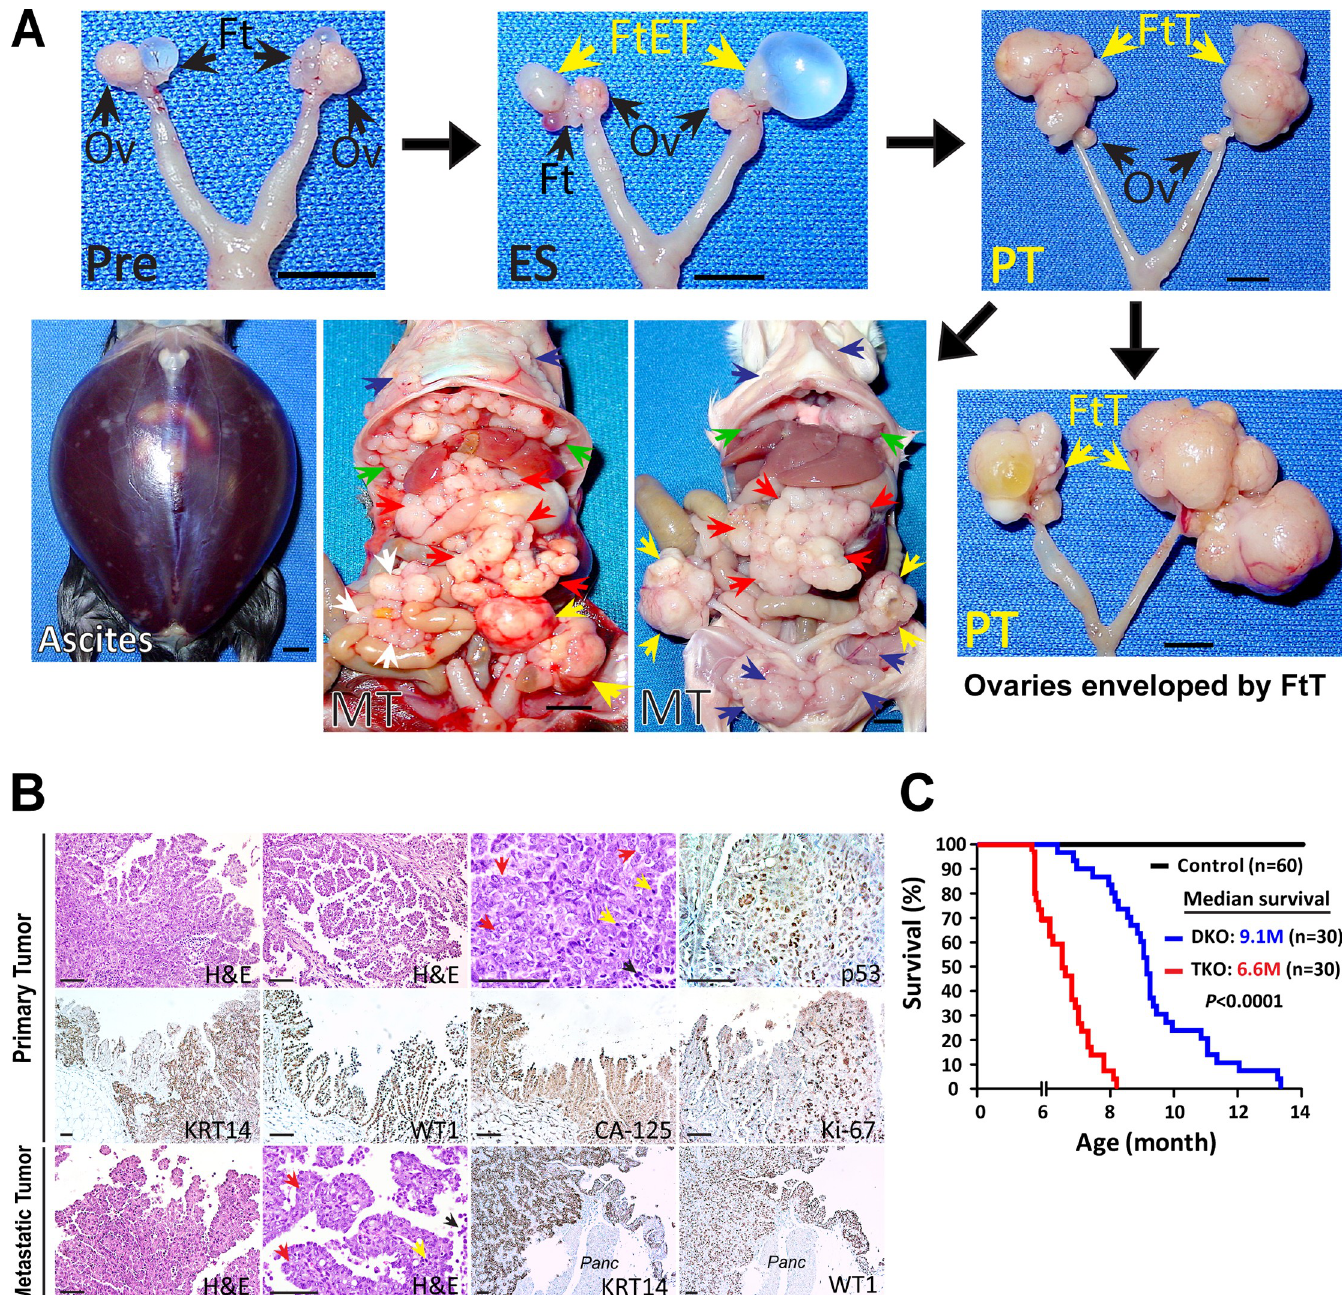
Fig 1. A mouse model with mutant p53 develops metastatic HGSC. A. A stepwise progression of metastatic HGSCs in TKO mice. At a premalignant stage (Pre), the fallopian tubes (Ft) form small cysts, which give rise to early tumors (FtET) at early stage (ES). The early-stage fallopian tube tumors (FtET) grow to become large fallopian tube tumors (FtT), while the ovaries (Ov) remain intact. The primary fallopian tube tumors (PT; FtT) (yellow arrows) expand and spread, enveloping the ovaries and disseminating throughout the pelvic and abdominal cavities to the omentum (red arrows), peritoneum (blue arrows), mesentery (white arrows), and diaphragm (green arrows). All mice develop widespread metastatic tumors (MT) with severe hemorrhagic ascites, leading to death. Scale bar, 0.5 cm. B. Histopathologic characterization of primary and metastatic HGSCs from TKO mice. The tumors display characteristic histopathological features of HGSC: a papillary, slit-like structure, along with a solid growth pattern, in which cancer cells exhibit intense mitosis (yellow arrows), abundant apoptosis (black arrows), pleomorphic and enlarged nuclei (red arrows), and prominent nucleoli with irregular chromatin aggregates (red arrows). In addition, mouse tumors are positive for several HGSC markers, including p53, WT1 (Wilms tumor 1), CA-125 (MUC16), and Ki-67 (MIB-1), and also are distinctively positive for the epithelial marker KRT14 (cytokeratin 14). Primary Tumor: primary fallopian tube tumors; Metastatic Tumor: omentum metastatic tumors; Panc: pancreas. H&E, hematoxylin & eosin. Scale bar, 100 μ m. C. Survival curves of TKO and DKO mice. Survival of TKO mice is significantly shorter than that of DKO mice. The median survival is 6.6 months for TKO